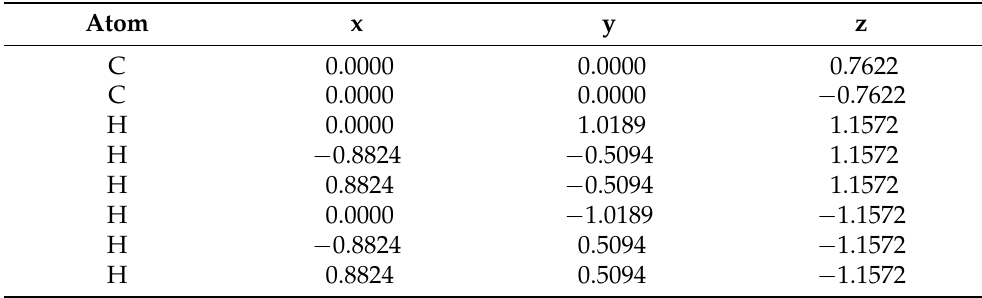
Table 2. Coordinate geometry of C 2 H 6 in Cartesian coordinate system (Angstroms)